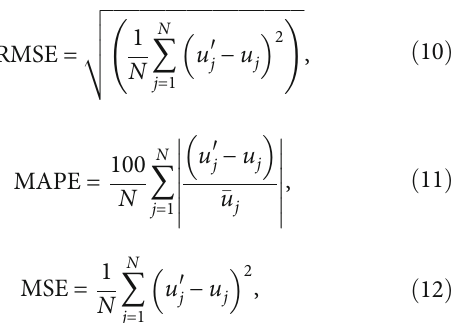
Figure 29: Prediction error vs. time for cloudy day three-hour- ahead